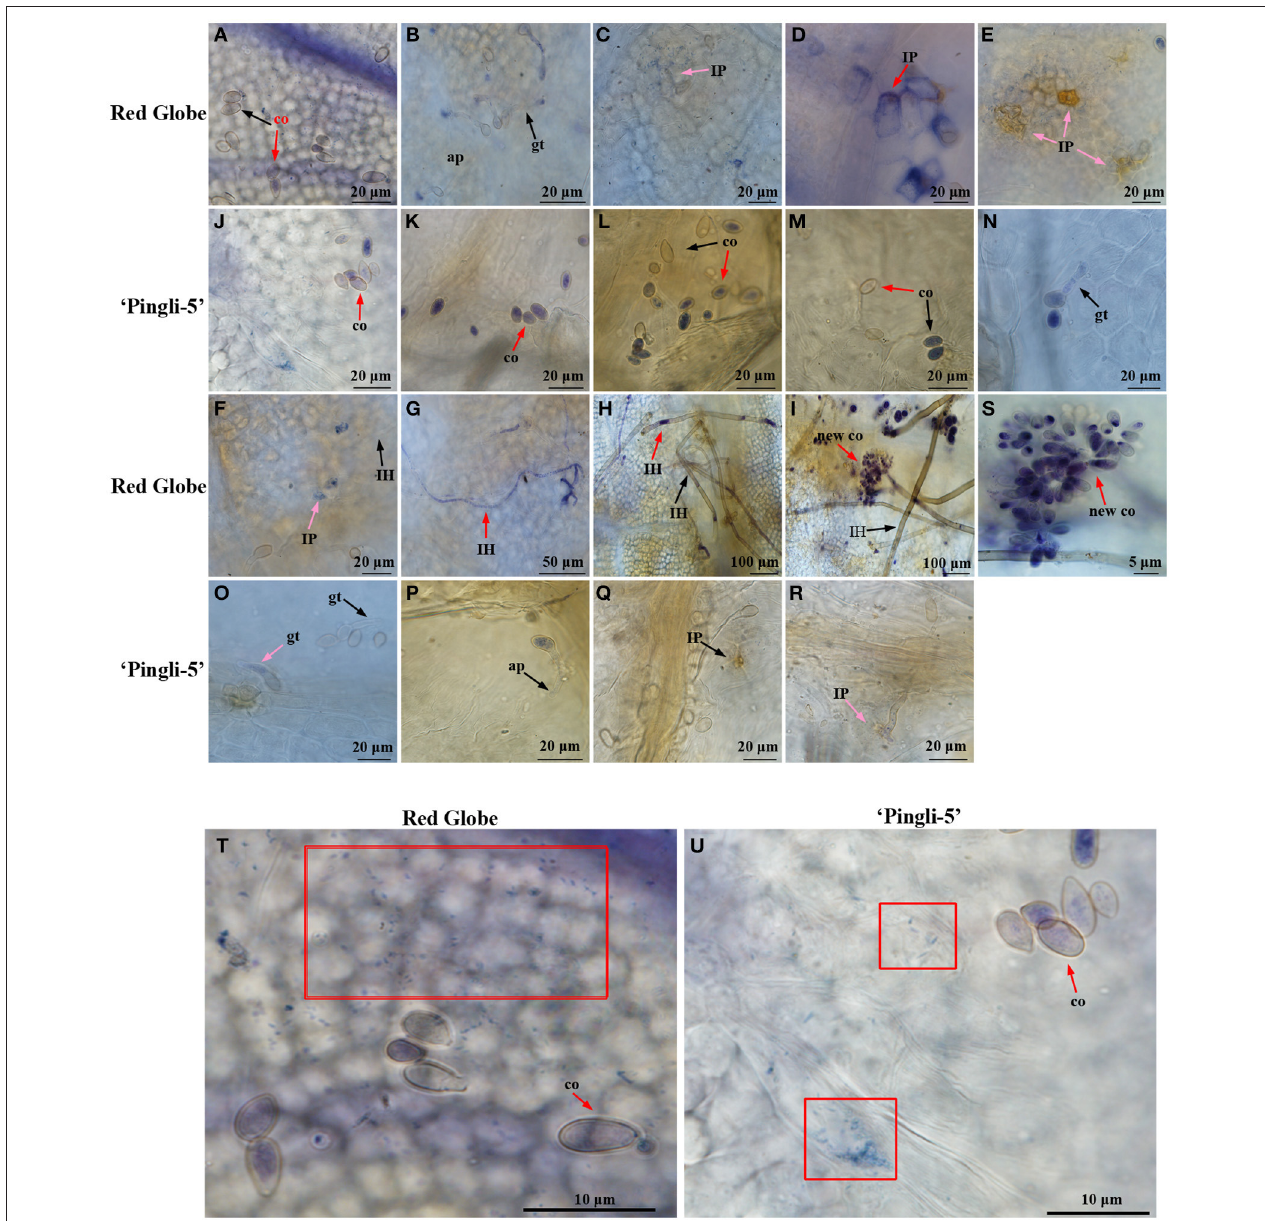
FIGURE 6 | Temporal evolution of O − 2 accumulation in the leaves of “Red Globe” and “Pingli-5” as well as in B. cinerea following inoculation. Nitroblue tetrazolium (NBT) stains O − 2 purple and was used to assess O − 2 accumulation in the interactions between B. cinerea and “Red Globe” (A–I) or “Pingli-5” (J–R) with B. cinerea 4, 8, 12, 18, 24, 36, 48, 72, and 96h post-inoculation (hpi). Arrows indicate a co, conidia; gt, germ tube; ap, appressorium; IP, infection peg, IH, infection hypha; and new co, new conidium. Black arrows indicate no NBT staining and red arrows indicate means DAB staining. (S) Higher magnification of the site of the red arrow in (I) , showing the NBT stained sporulation. (T,U) O − 2 accumulation 4 hpi in the leaves of “Red Globe” (T) and “Pingli-5” (U) infected with B. cinerea . Red blocks indicate wispy and small NBT stained spots in cells of both Vitis genotypes. Arrows indicate a NBT stained conidium (co). Scale bar: (A–F) : 20 µ m; (G) : 50 µ m; (H,I) : 100 µ m; (J–R) : 20 µ m; (S) : 5 µ m; (T,U) : 10 µ